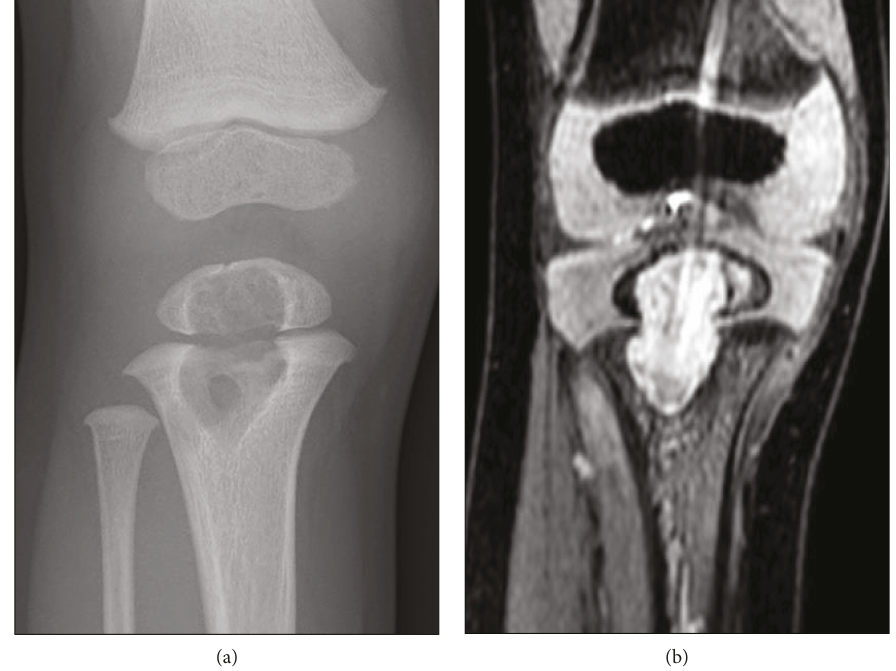
Figure 2: After treatment with intravenous antibiotic chemotherapy. (a) Plain radiograph showing the epiphyseal radiolucent lesion extending to the metaphysis through the physis at the right proximal tibia. (b) MRI demonstrating an abnormality at the same site, extending across the high-signal intensity area of the physis in the three-dimensional fast fi eld echo